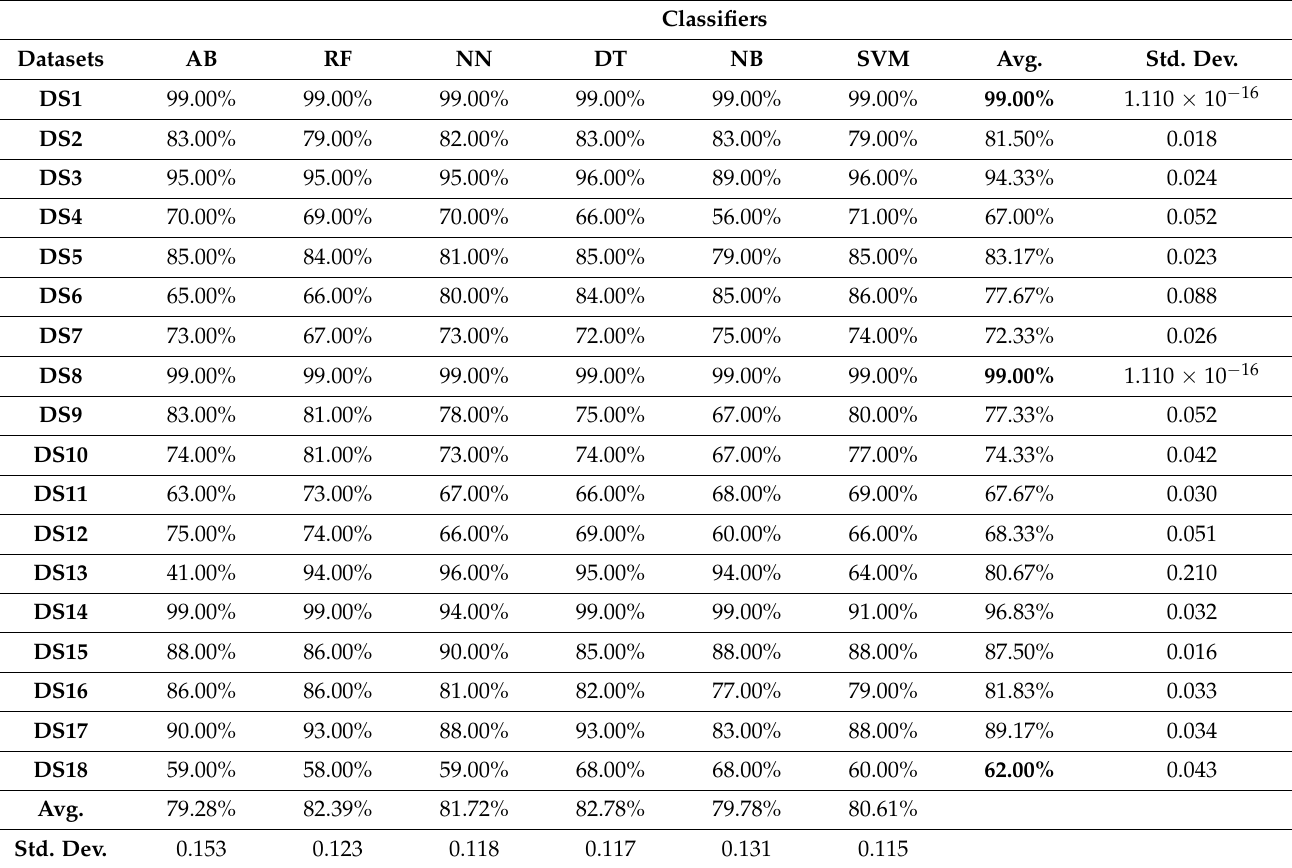
Table 5. Accuracy of classifiers trained on small